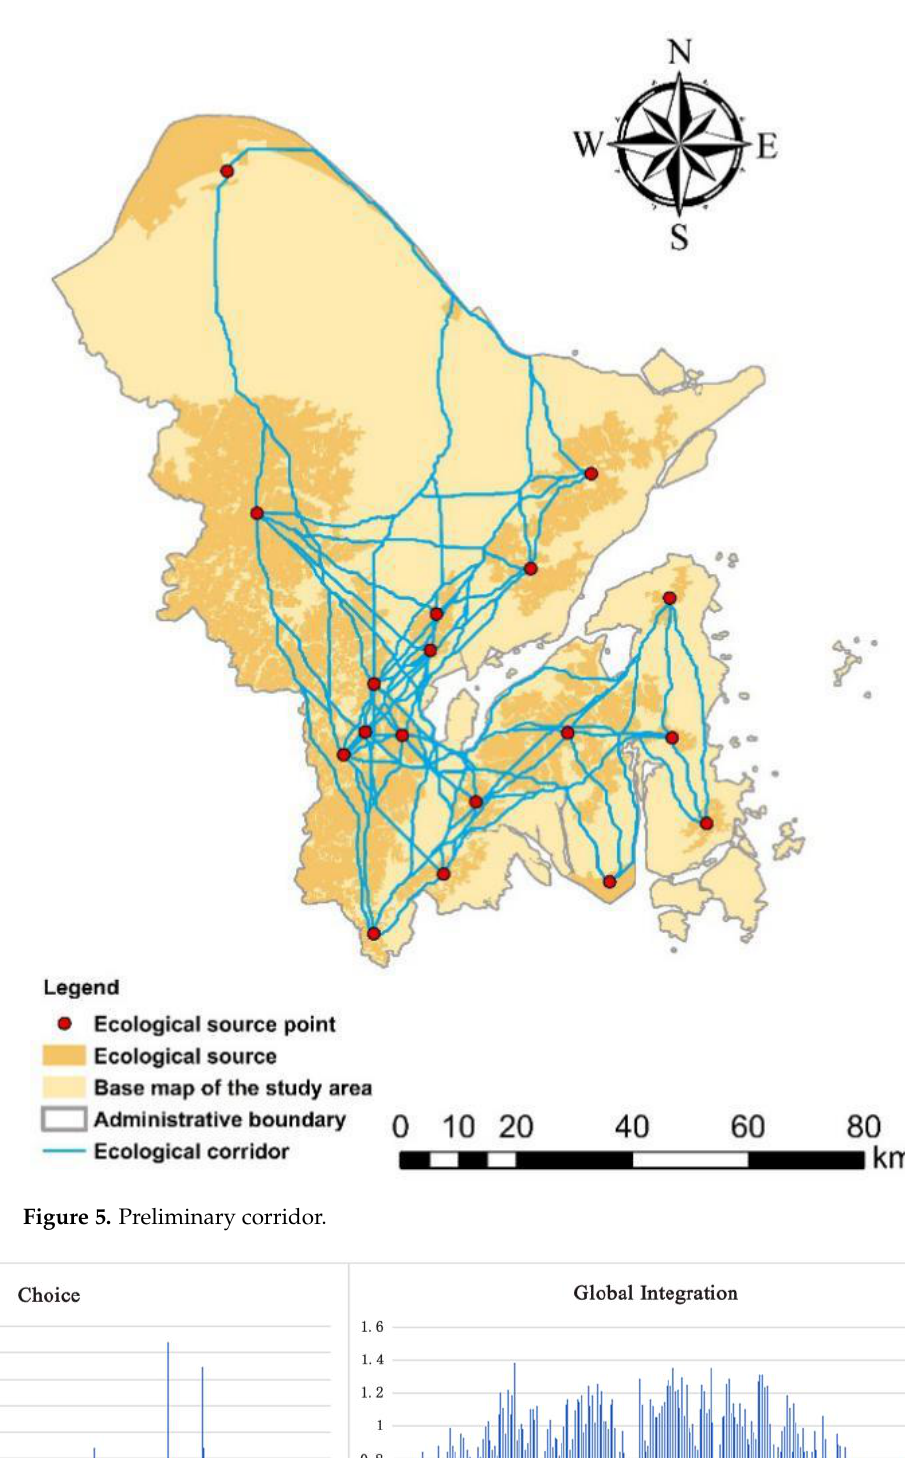
Figure 5. Preliminary corridor. Fig. 5. Preliminary corridor.